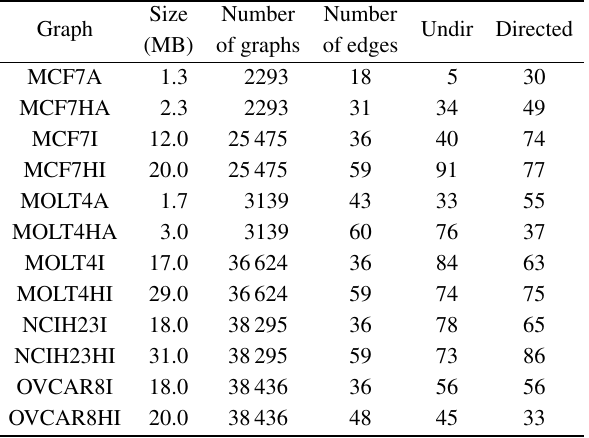
Table 7 SparkFSM [27] performance analysis on biological graphs (time in seconds, threshold frequency: 50%).